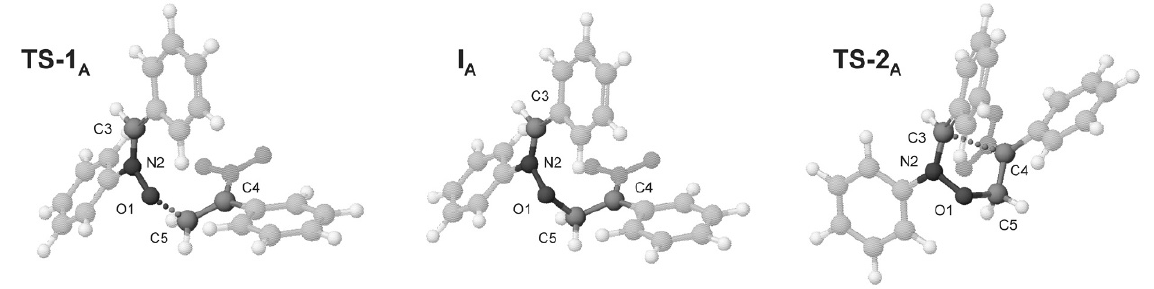
Figure 4. Critical structures from the [2+3] cycloaddition 1+2 → 3 in nitromethane according to B3LYP/6-31G(d)/PCM